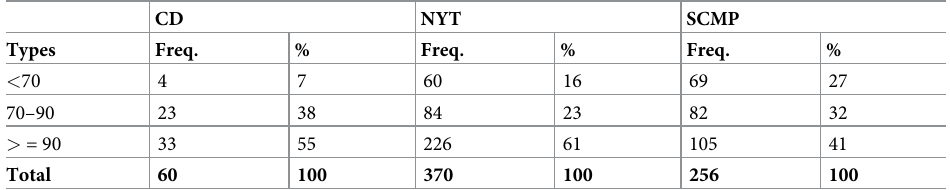
Table 2. Distribution of numbers in three